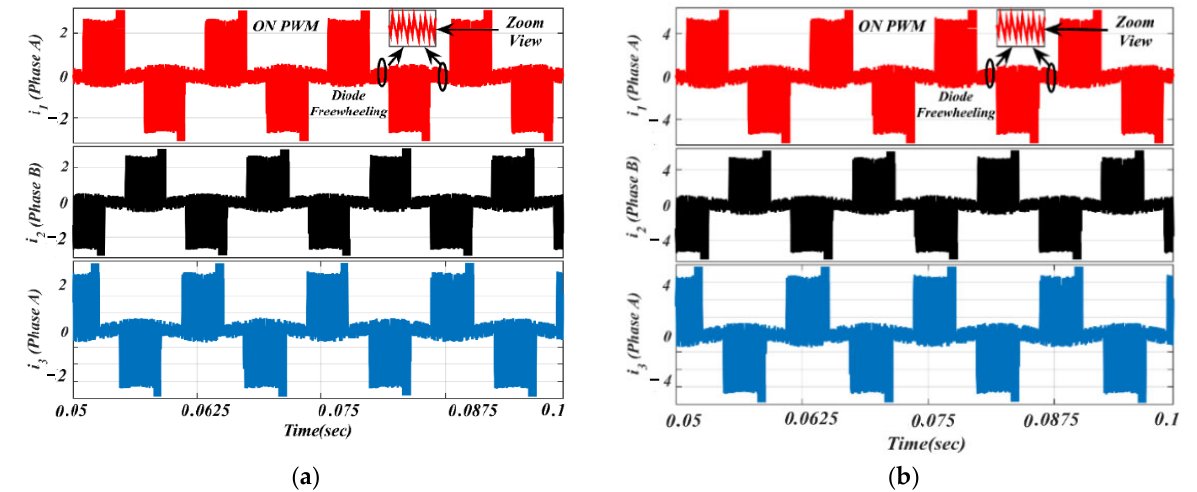
Figure 12. Simulated waveforms of the phase current based on ON ‐ PWM scheme: ( a ) lightly loaded or partially loaded (40% of maximum load); and ( b ) full load (85% of maximum load).